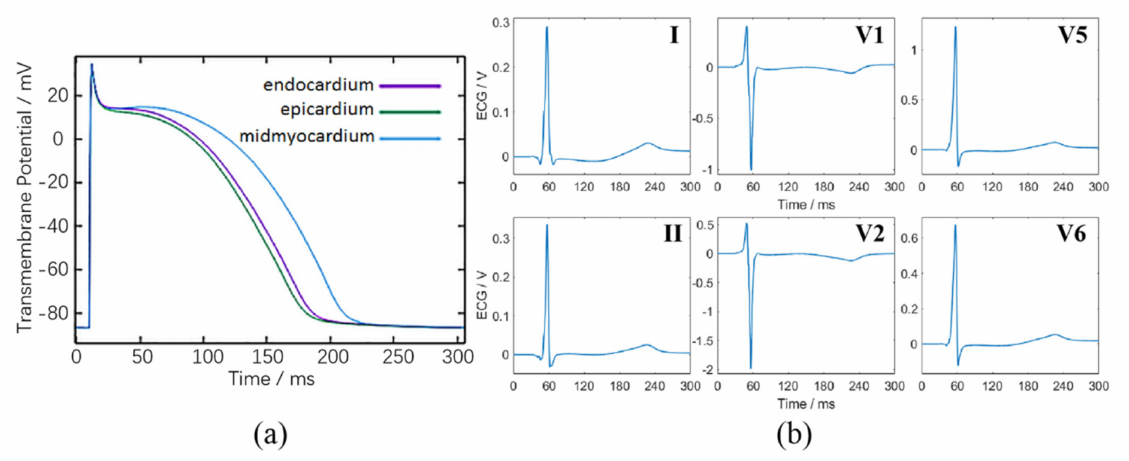
Figure 3. ( a ) Simulated action potentials under steady state for the cells from endocardium, epicardium, and midmy- ocardium. ( b ) The synthetic ECG in the normal ventricle.